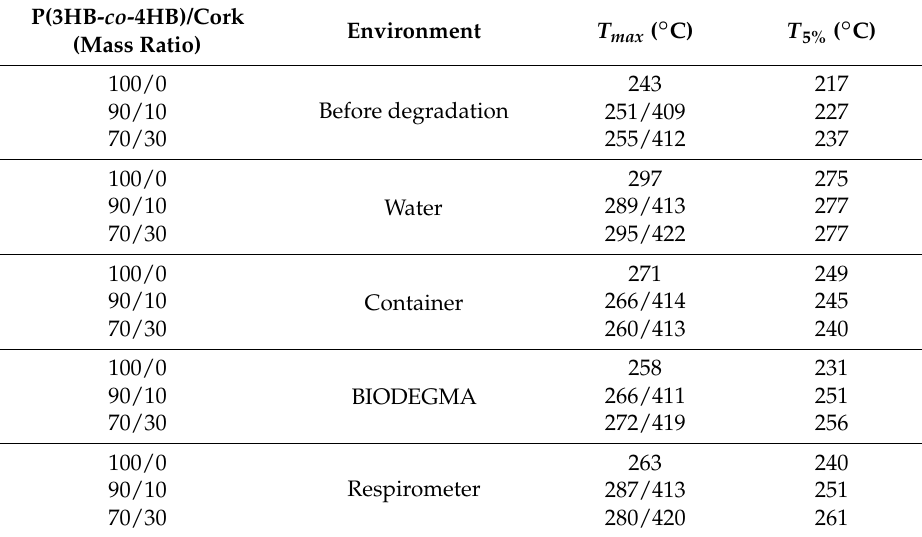
Table 3. Thermogravimetric parameters before and after 21 days of degradation of pure P(3HB- co -4HB) and P(3HB- co -4HB)/cork